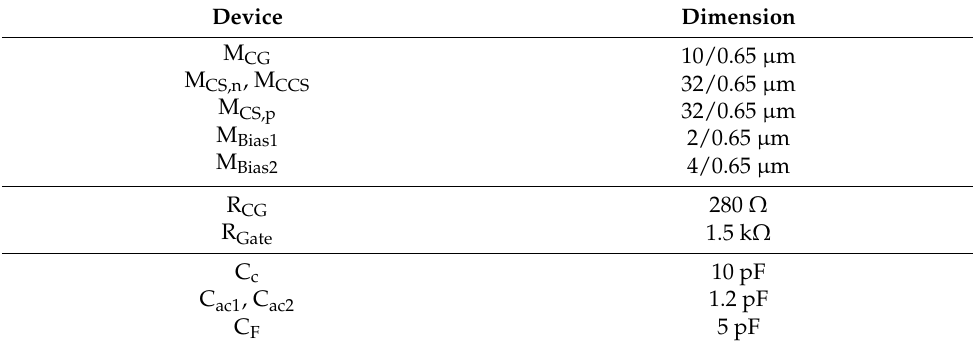
Table 1. Device dimension and bias